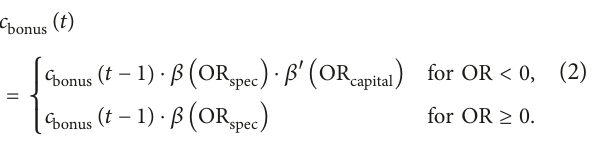
Table 3: Definition of bonus parameters 𝛽 and 𝛽 󸀠 depending on = C / operating results (OR); that is, OR capital